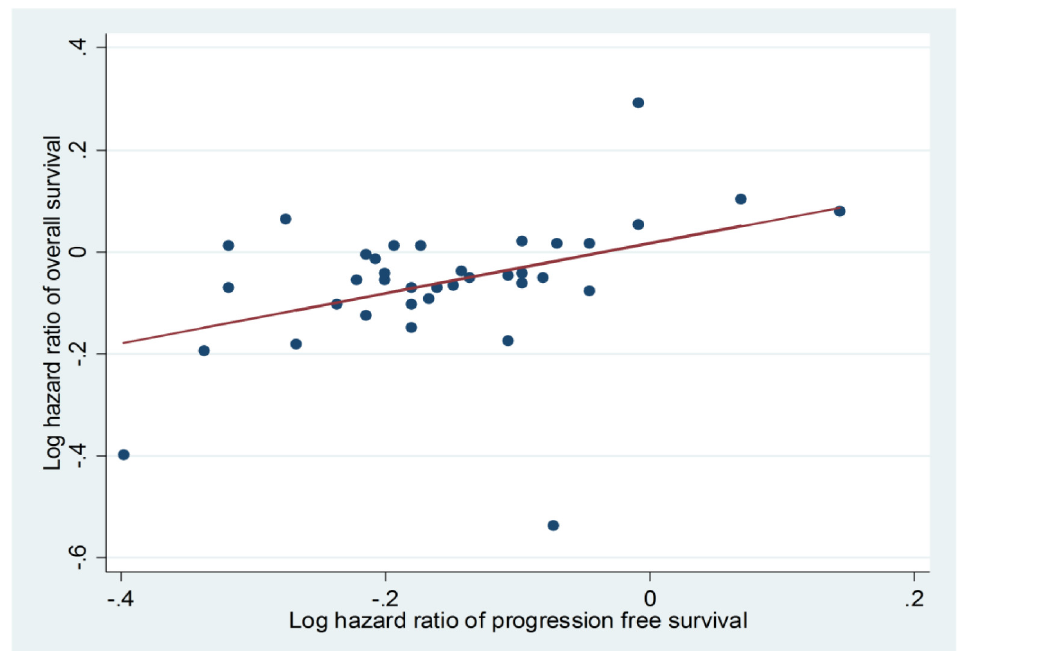
Fig 5. Spearman ’ s correlation between progression free survival and overall